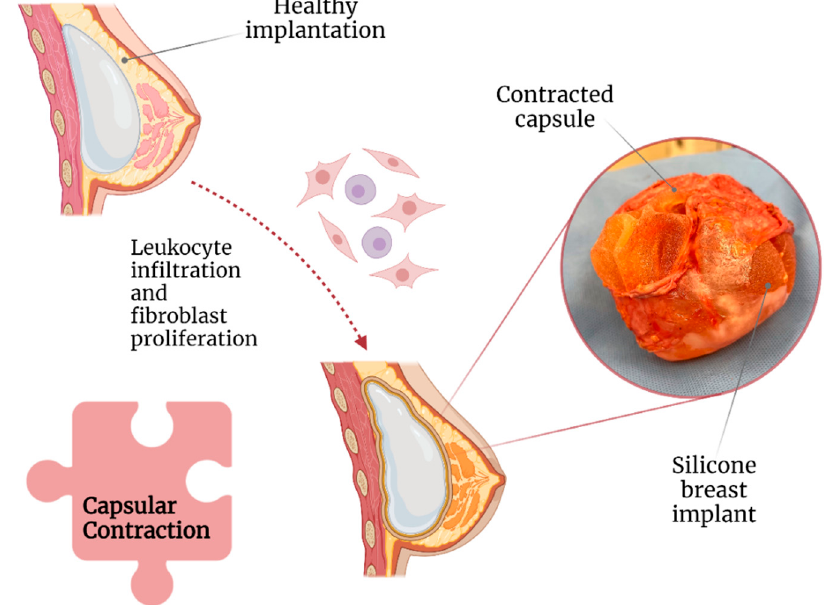
Figure 2. Association of capsular contraction with breast implant illness.